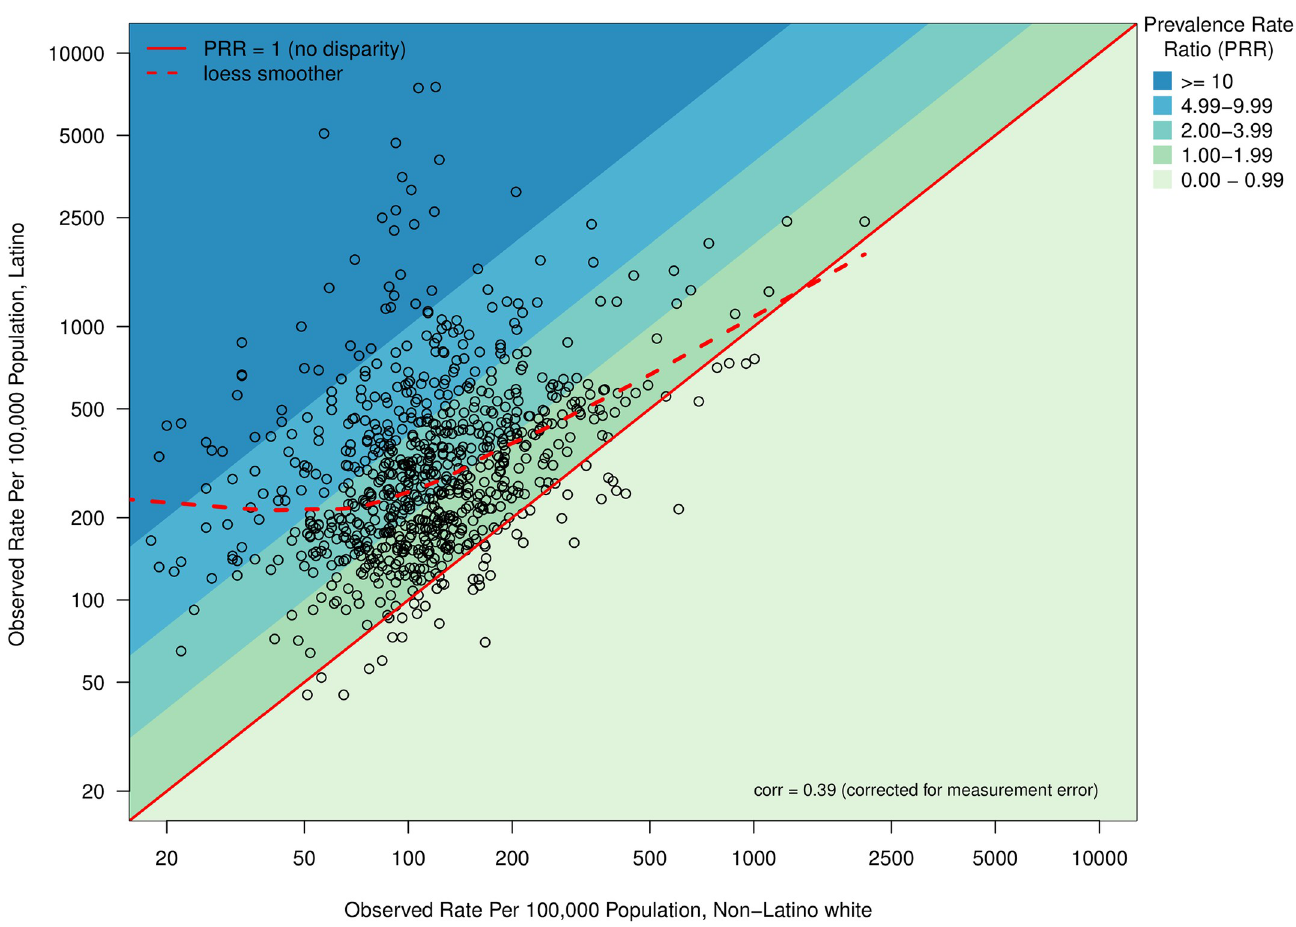
Fig 1. Observed Latino and Non − Latino white diagnosed HIV prevalence rate (N = 775